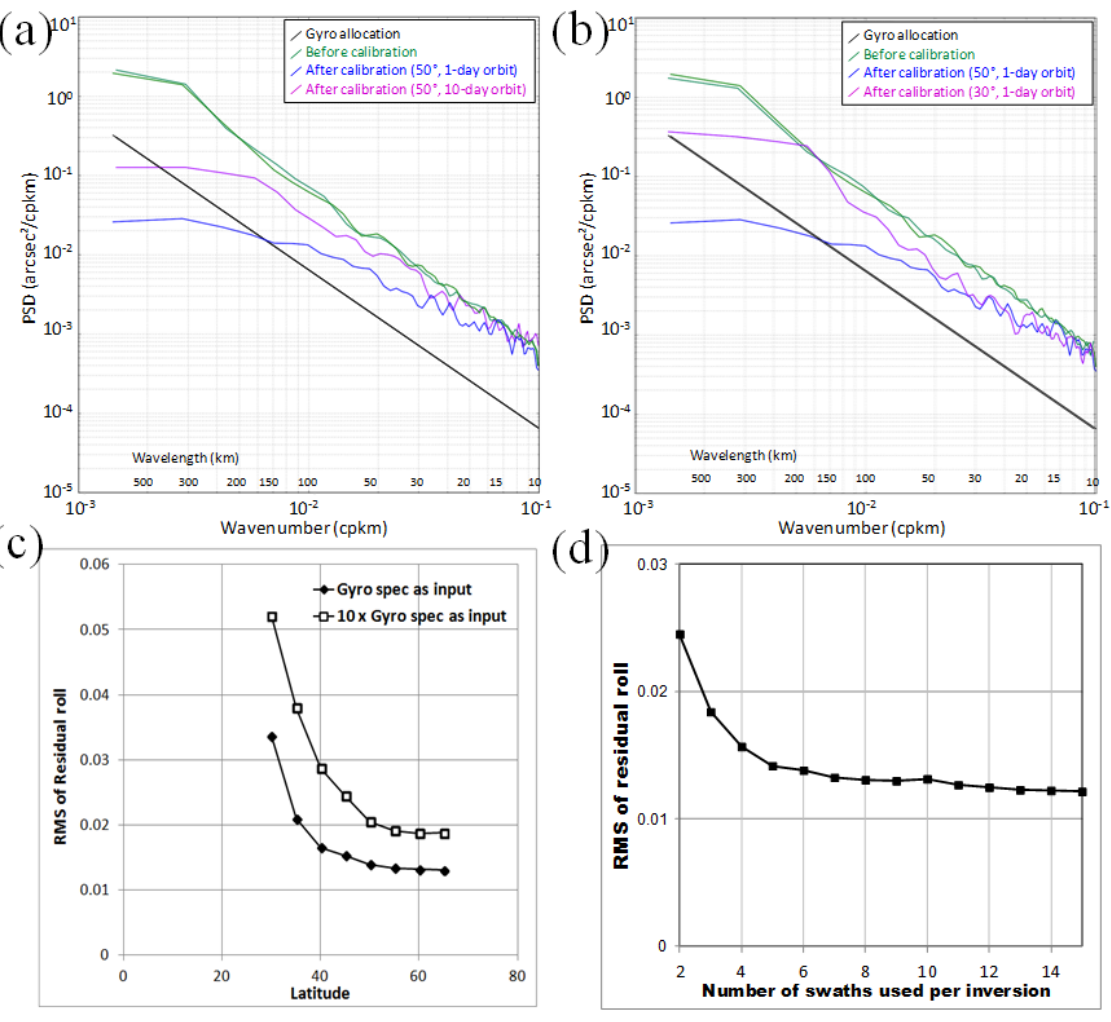
Figure 21. Performance of the sub-cycle calibration method. ( a ) shows the roll error PSD after sub-cycle cross-calibration at a latitude of 50° for the baseline 10-day sub-cycle orbit (purple) and for the contingency one-day sub-cycle orbit (blue), and the roll error before calibration (green for both simulations). ( b ) shows the roll error PSD after sub-cycle cross-calibration for the one-day sub-cycle orbit at a latitude of 50° (blue) and at a latitude of 30° (purple), and the roll error before calibration (green for both simulations). ( c , d ) show in arcsec the RMS of the calibrated roll residuals as a function of latitude (c), and as function of the number of adjoining swaths used concurrently in an inversion performed at 45°